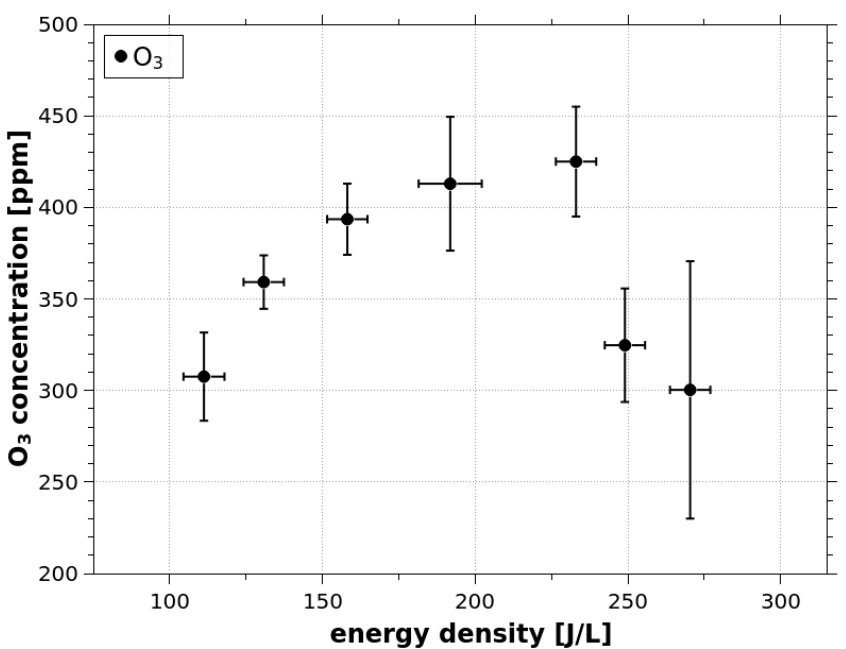
Figure 8. O 3 concentration as a function of the TS input energy density, dry O 2 treated by TS in 1SS without ES, measured by UV-Vis absorption technique, short absorption cell.